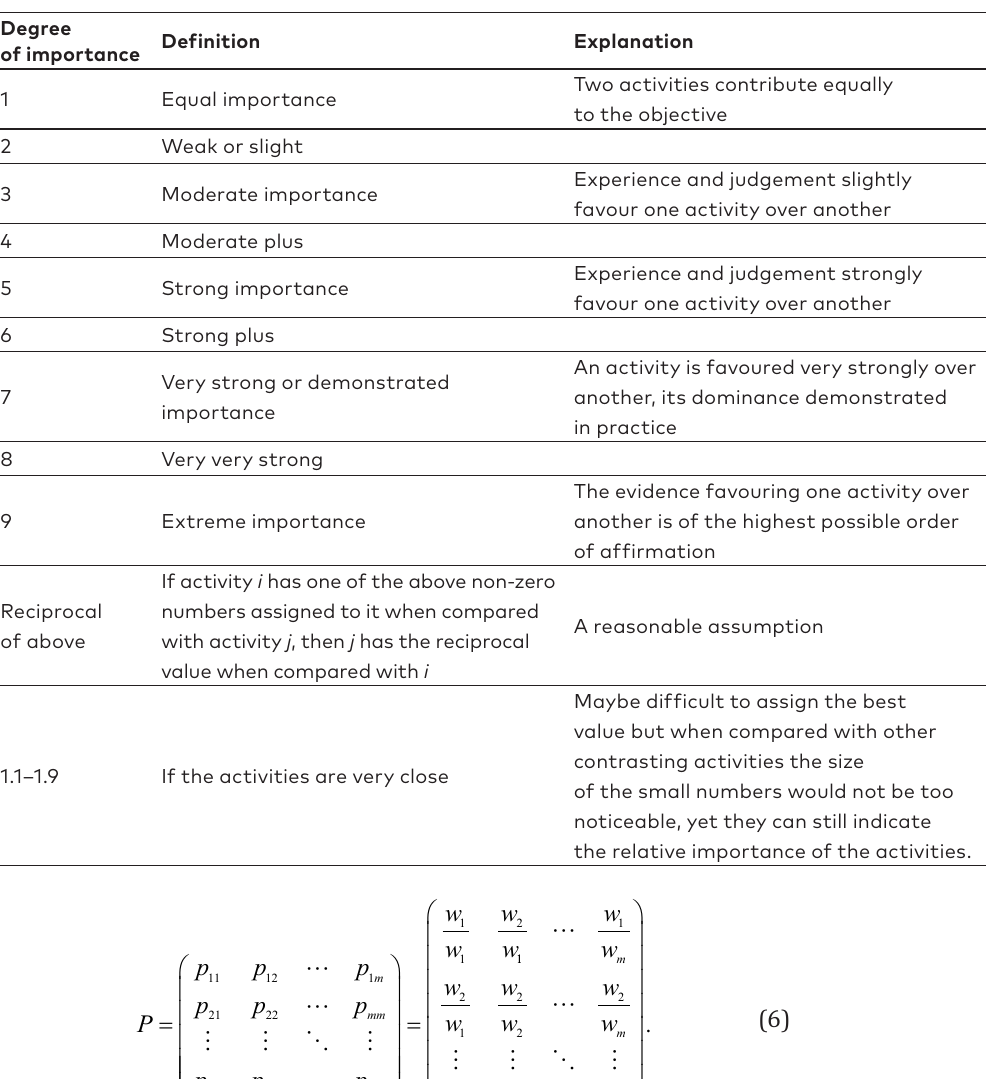
Table 4. The fundamental